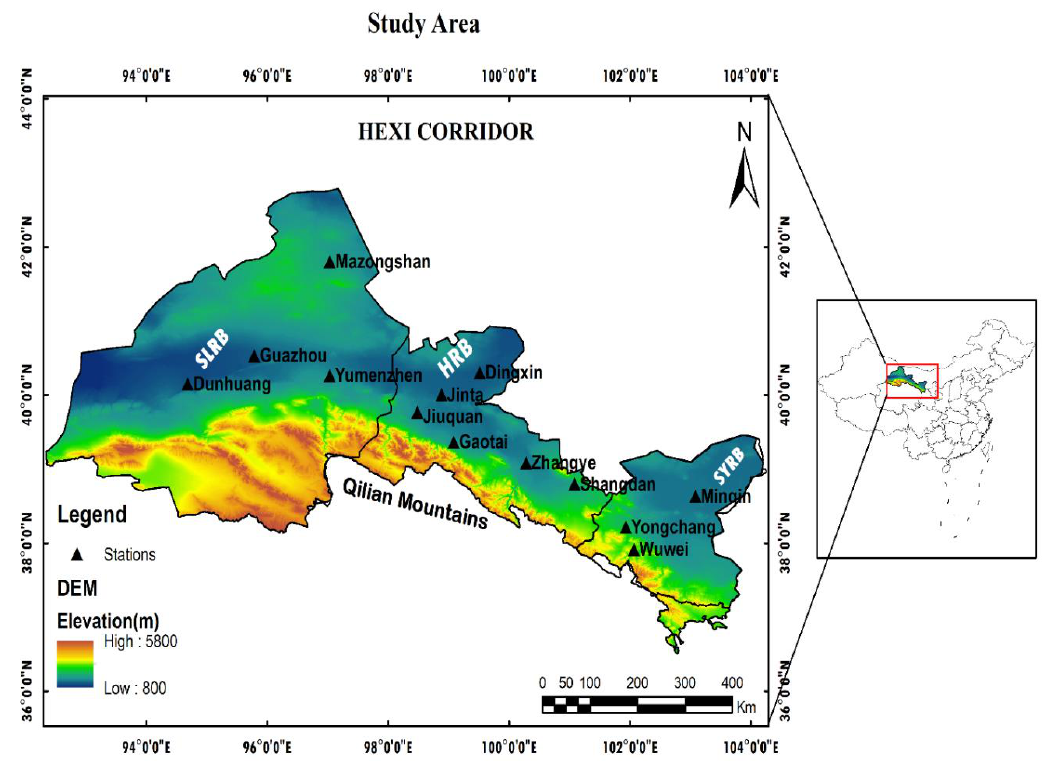
Figure 1. Digital elevation model (DEM) of Hexi Corridor, and distribution of meteorological stations in three inland river basins namely Shule river basin (SLRB), Heihe river basin (HRB), and Shiyang river basin (SYRB).